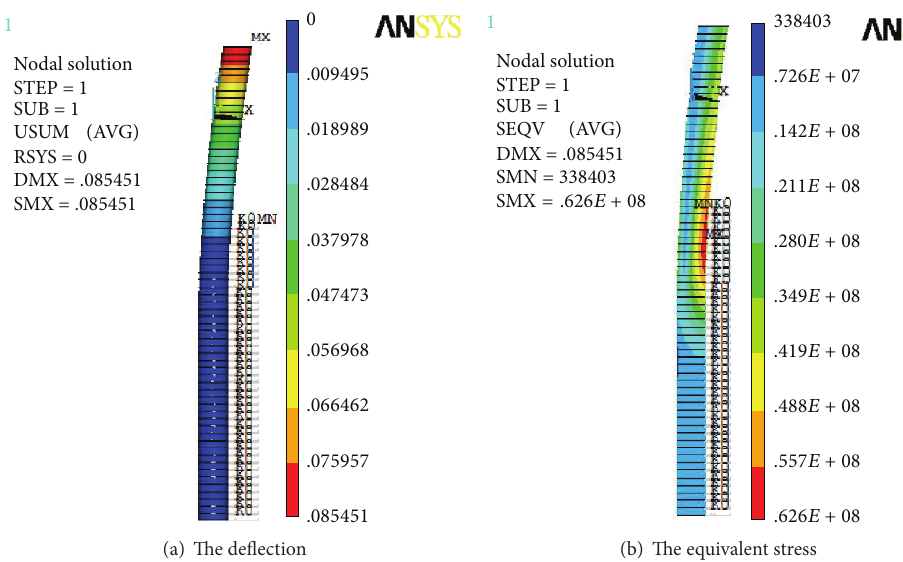
Figure 3: Deformation and stress of pile foundation under normal operation condition when 𝑡 = 10 a.